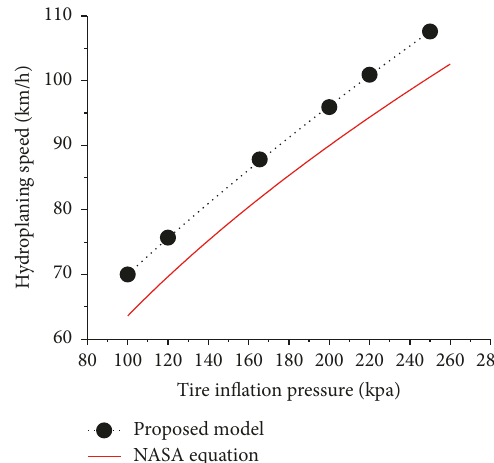
Figure 12: Hydroplaning speed calculated from proposed model and NASA